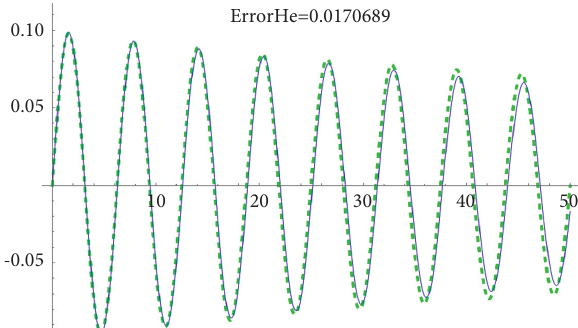
Figure 2: He’s homotopy method-error comparison with the Runge–Kutta numerical solution.